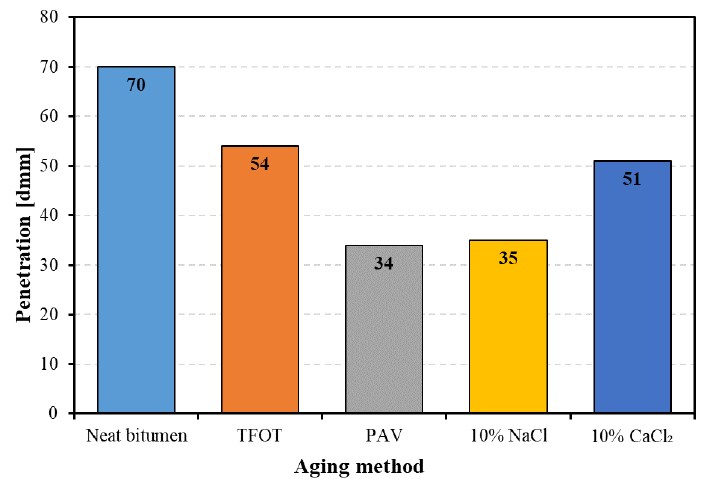
Figure 3. The penetration of bitumen before and after aging.